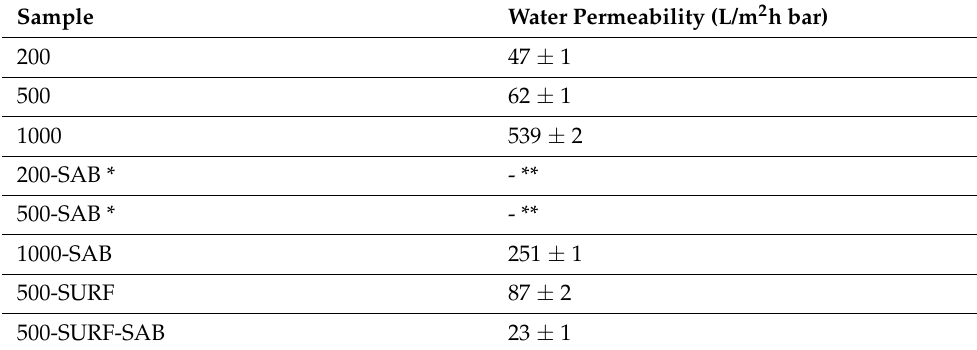
Table 2. Water permeability of the prepared membranes.